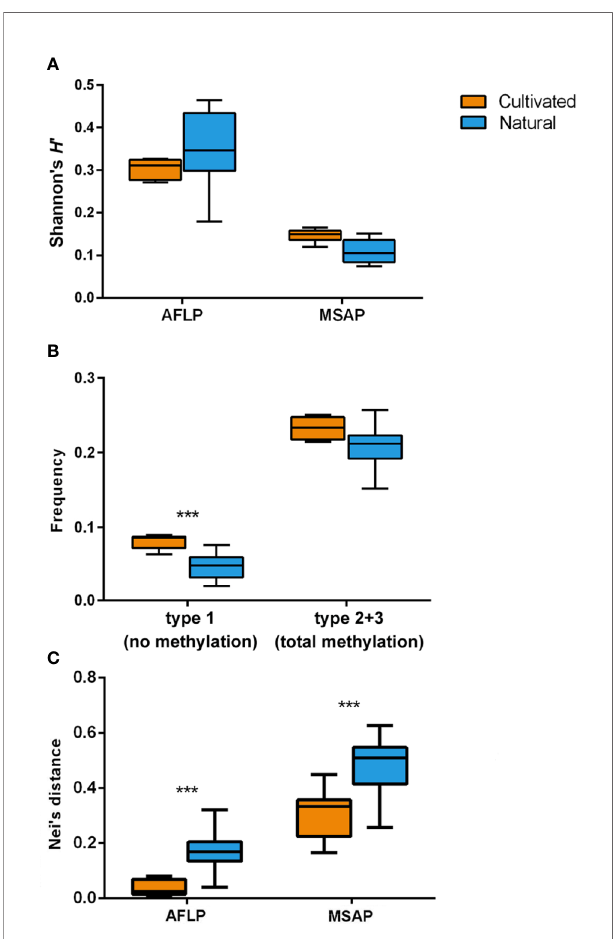
FIGURE 2 | Magnitudes of genetic and epigenetic variation between natural and cultivated C. yanhusuo populations using methylation sensitive ampli fi ed polymorphism (MSAP) and ampli fi ed fragment length polymorphism (AFLP). (A) Shannon ’ s diversity ( H ′ ); (B) frequency of two types of methylation, including type 1 (no methylation), type 2+3 (total methylation); and (C) Nei ’ s distance. Boxplots indicate medians, 25th and 75th percentiles, minimum and maximum values. Signi fi cance between natural and cultivated populations in (B, C) based on Duncan tests with 10 4 replications is indicated as: *** P <